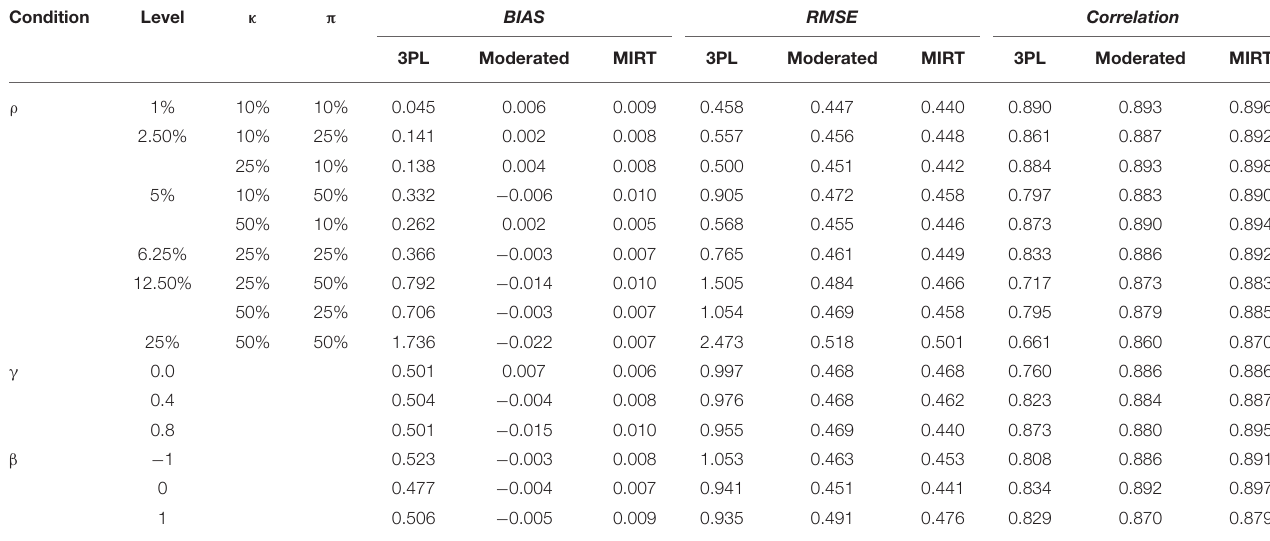
TABLE 2 | BIAS, RMSE, and correlation for ability estimates in study I. Condition BIAS RMSE Correlation